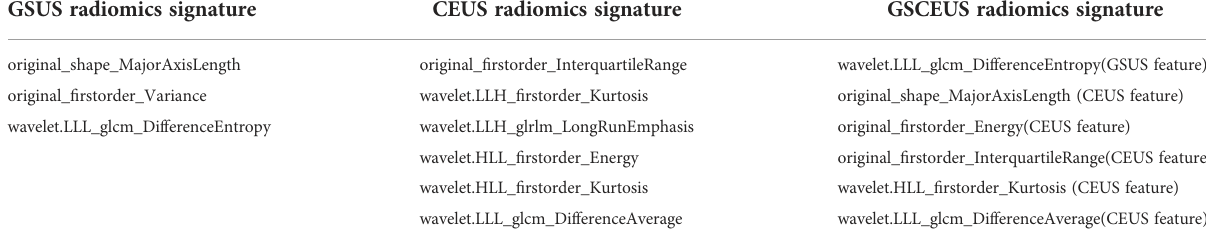
TABLE 2 Radiomics features of three radiomics